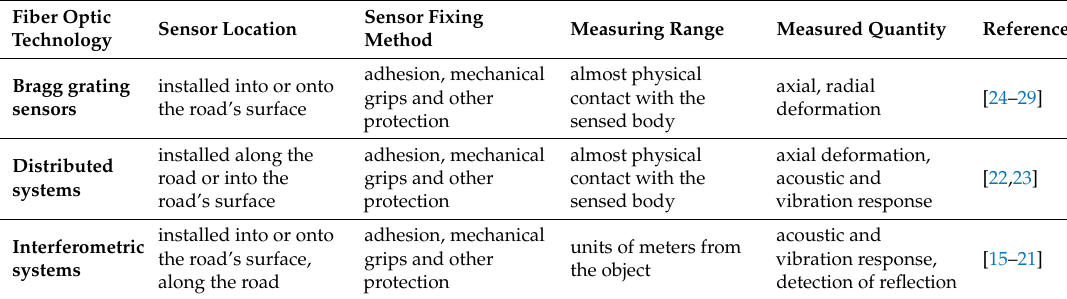
Table 1. Summary of the use of basic types of fiber optic sensors in road transport.